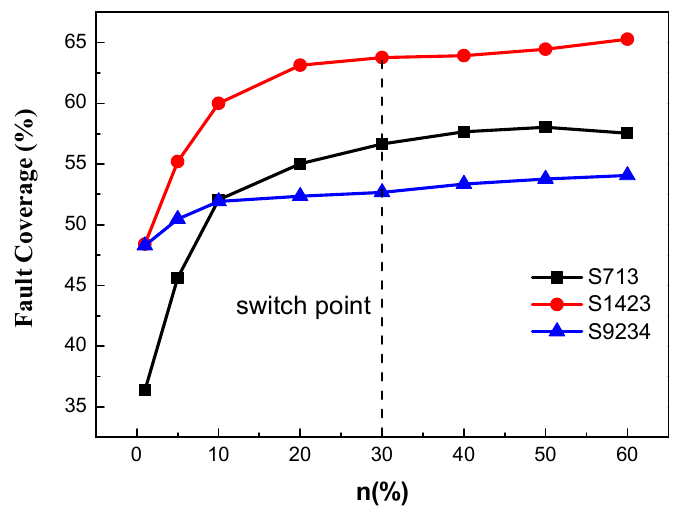
Figure 4. Pseudorandom patterns generate curve of the fault coverage varying with n and the algo- rithm switching point.